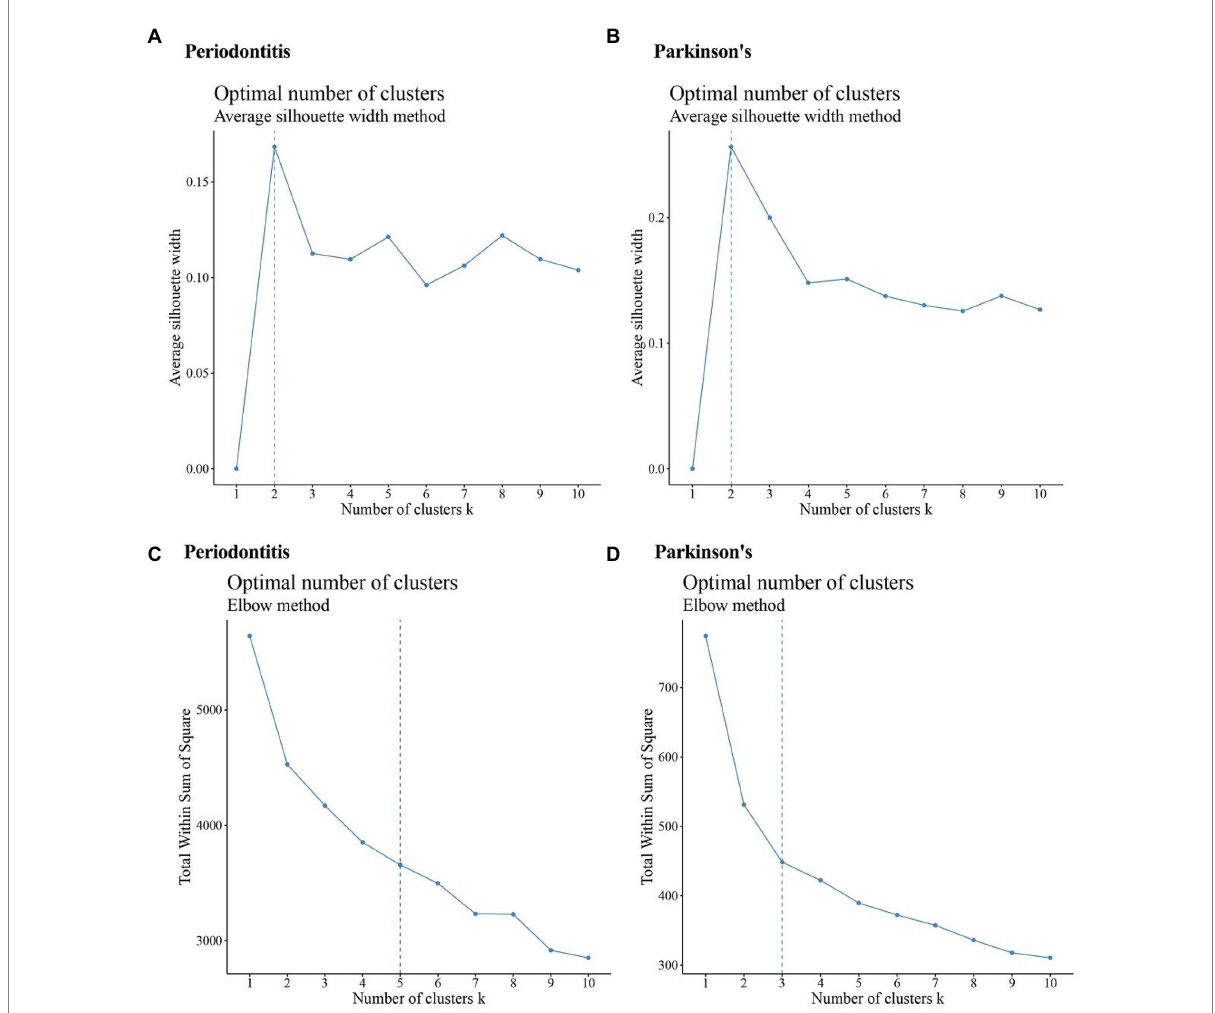
FIGURE 6 Results of a cluster analysis of periodontitis and Parkinson’s disease. (A,B) Results of a silhouette width analysis of the IRRGs associated with periodontitis and the average of IRRGs associated with Parkinson’s disease; (C,D) Results of an elbow method analysis of Periodontitis disease- related IRRGs and Parkinson’s disease-related